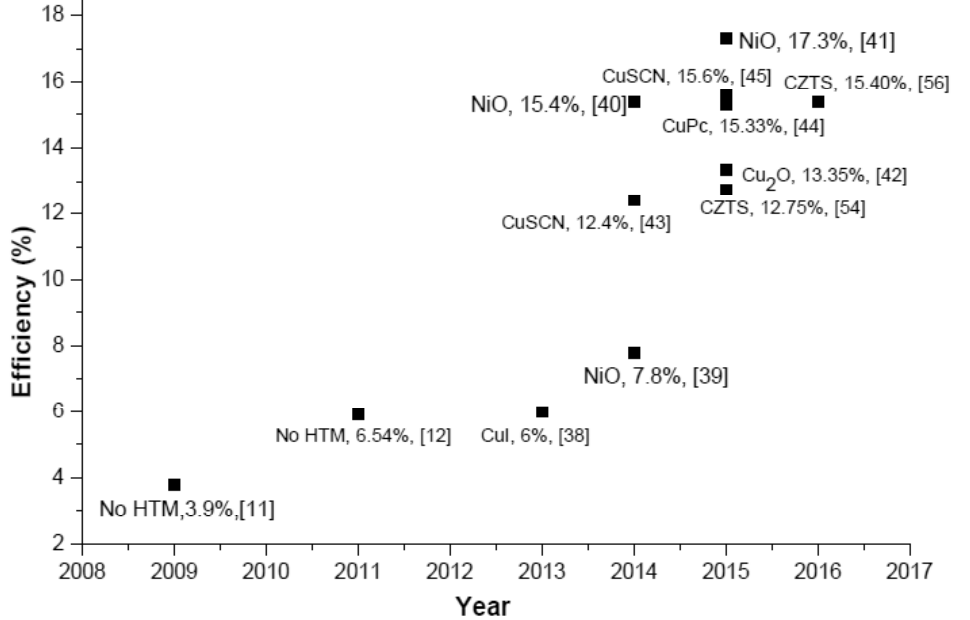
Fig. 3. Progress in efficiency of perovskite solar cell using inorganic/cheap HTM.